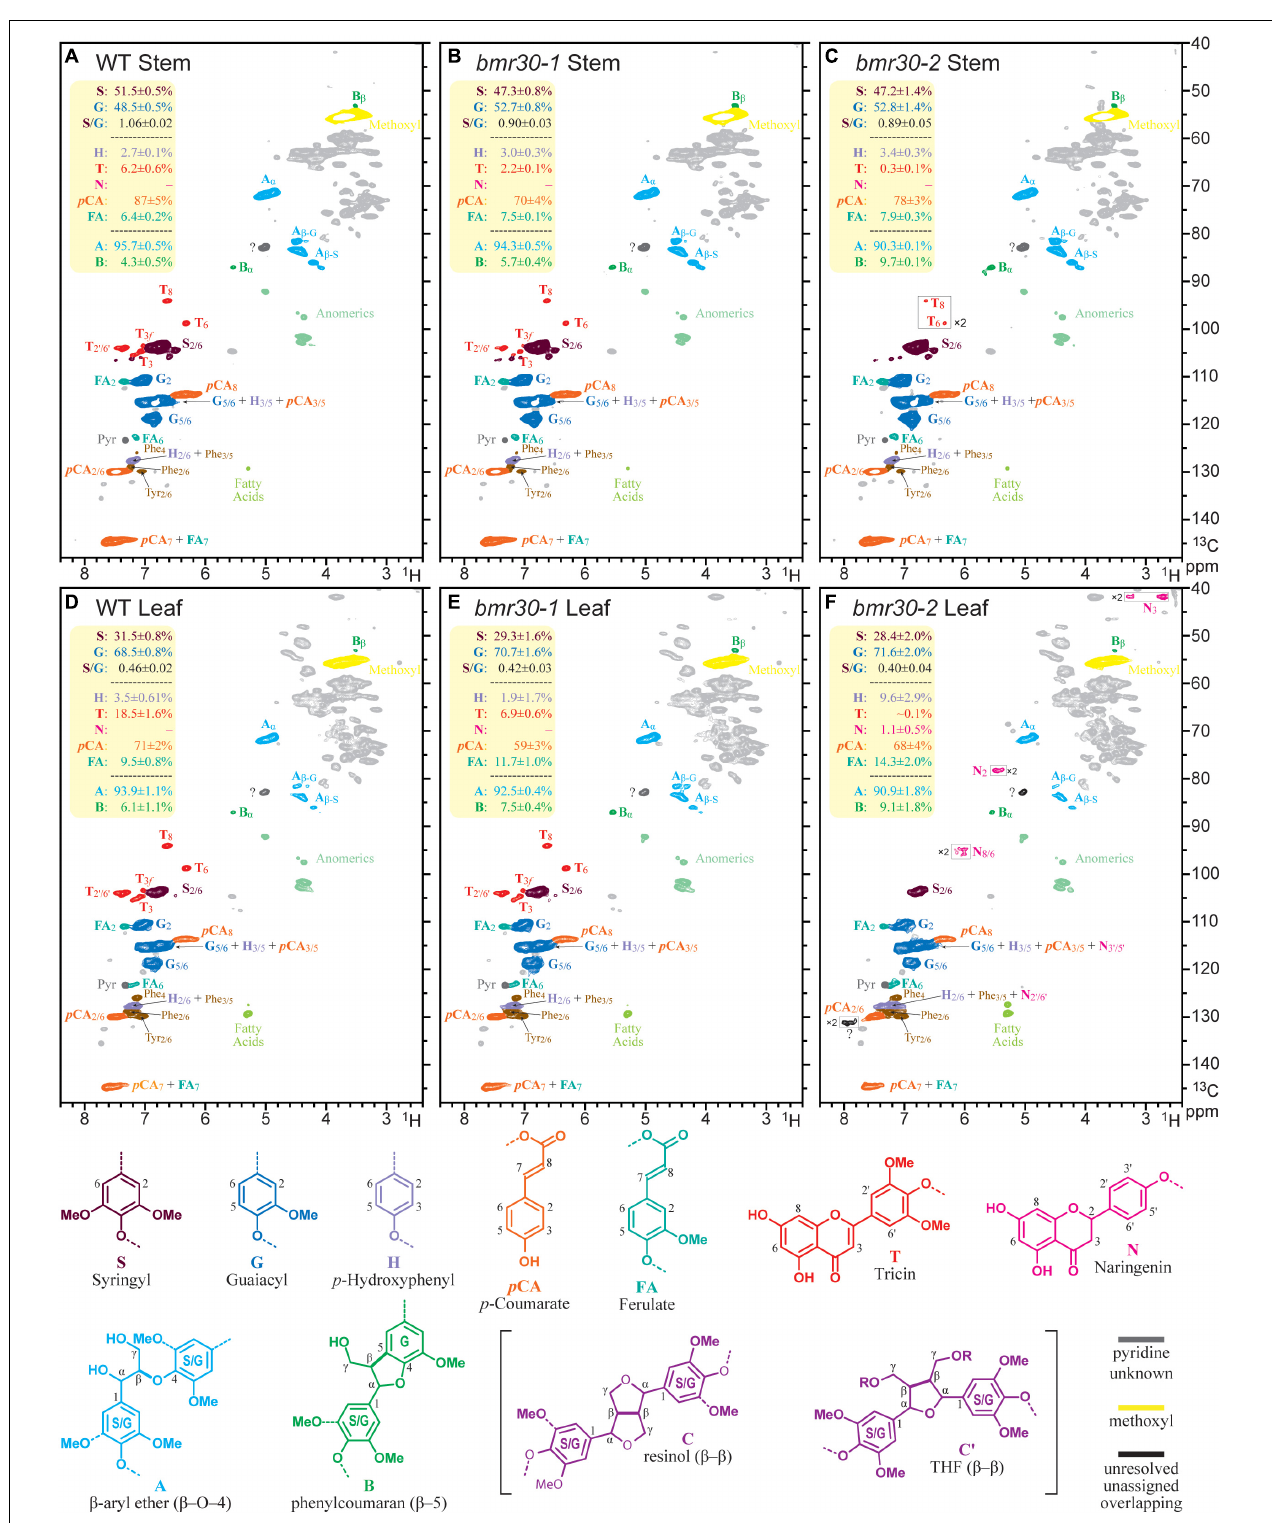
FIGURE 9 | Partial 2D HSQC NMR spectra (in 4:1 DMSO-d 6 /pyridine-d 5 ) of the enzyme lignin (EL) preparations isolated from the wild-type and bmr30 lines. (A–C) Spectra of ELs from the stems of wild type (WT), and the bmr30-1 , and bmr30-2 mutants. (D–F) Analogous spectra from the leaf ELs. Each plotted spectrum is a representative from a set of 4 biological replicates for each; the integral data in the top-left yellow-backgrounded panel of each presents the average and standard